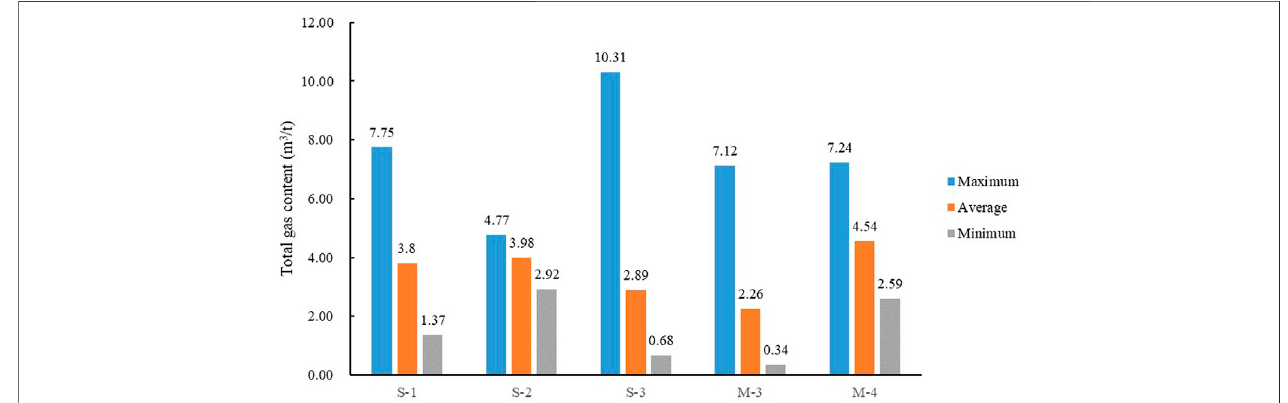
FIGURE 6 | The total gas content of different shale lithofacies of the Longmaxi Formation in the Changning area.